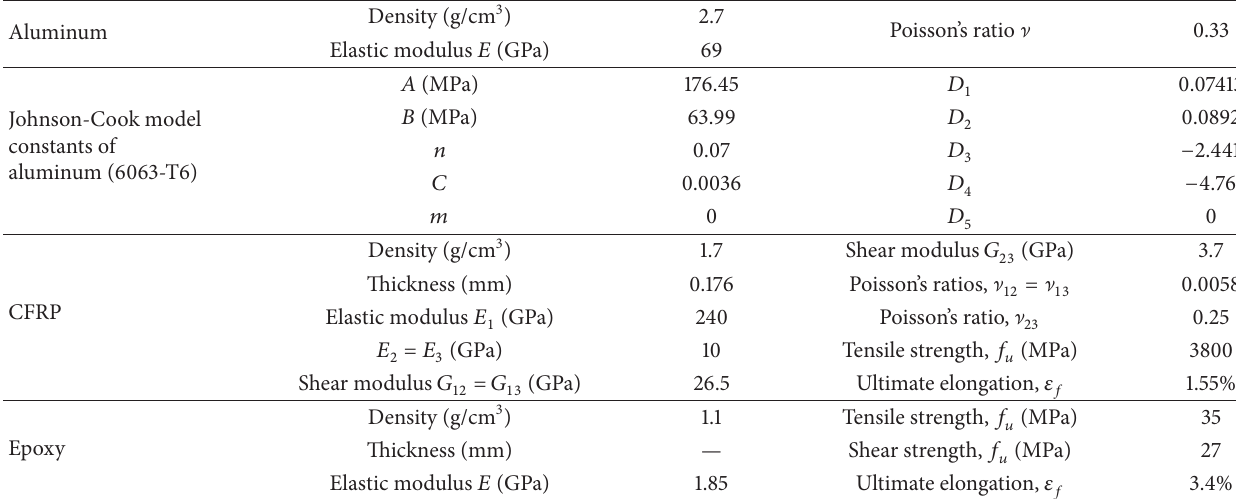
Table 1: Material properties [8, 21, 44].